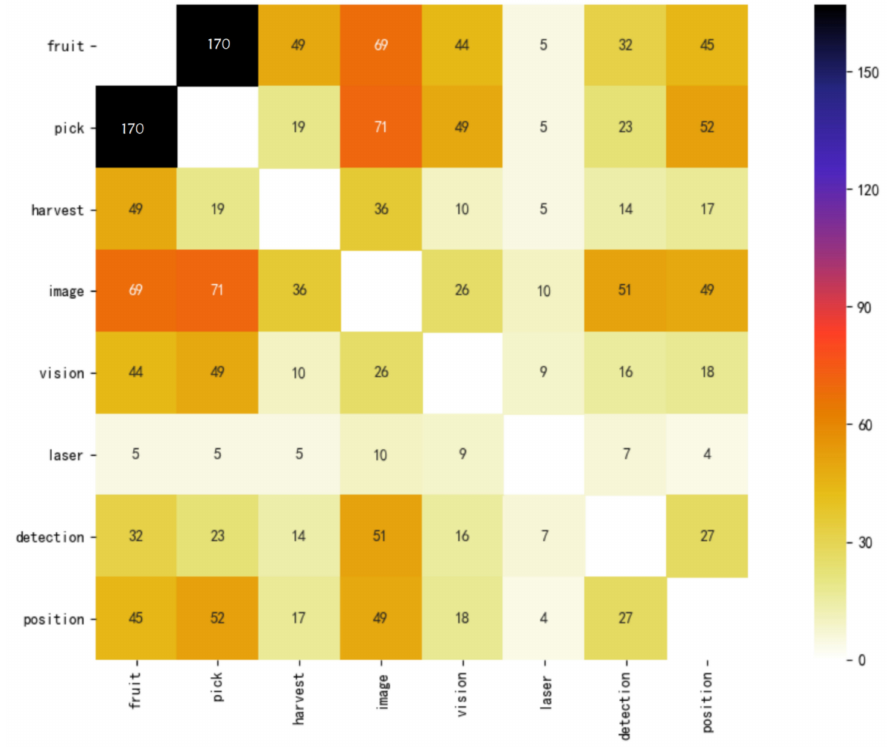
Figure 11. Keyword co-occurrence matrix of position for a fruit harvesting